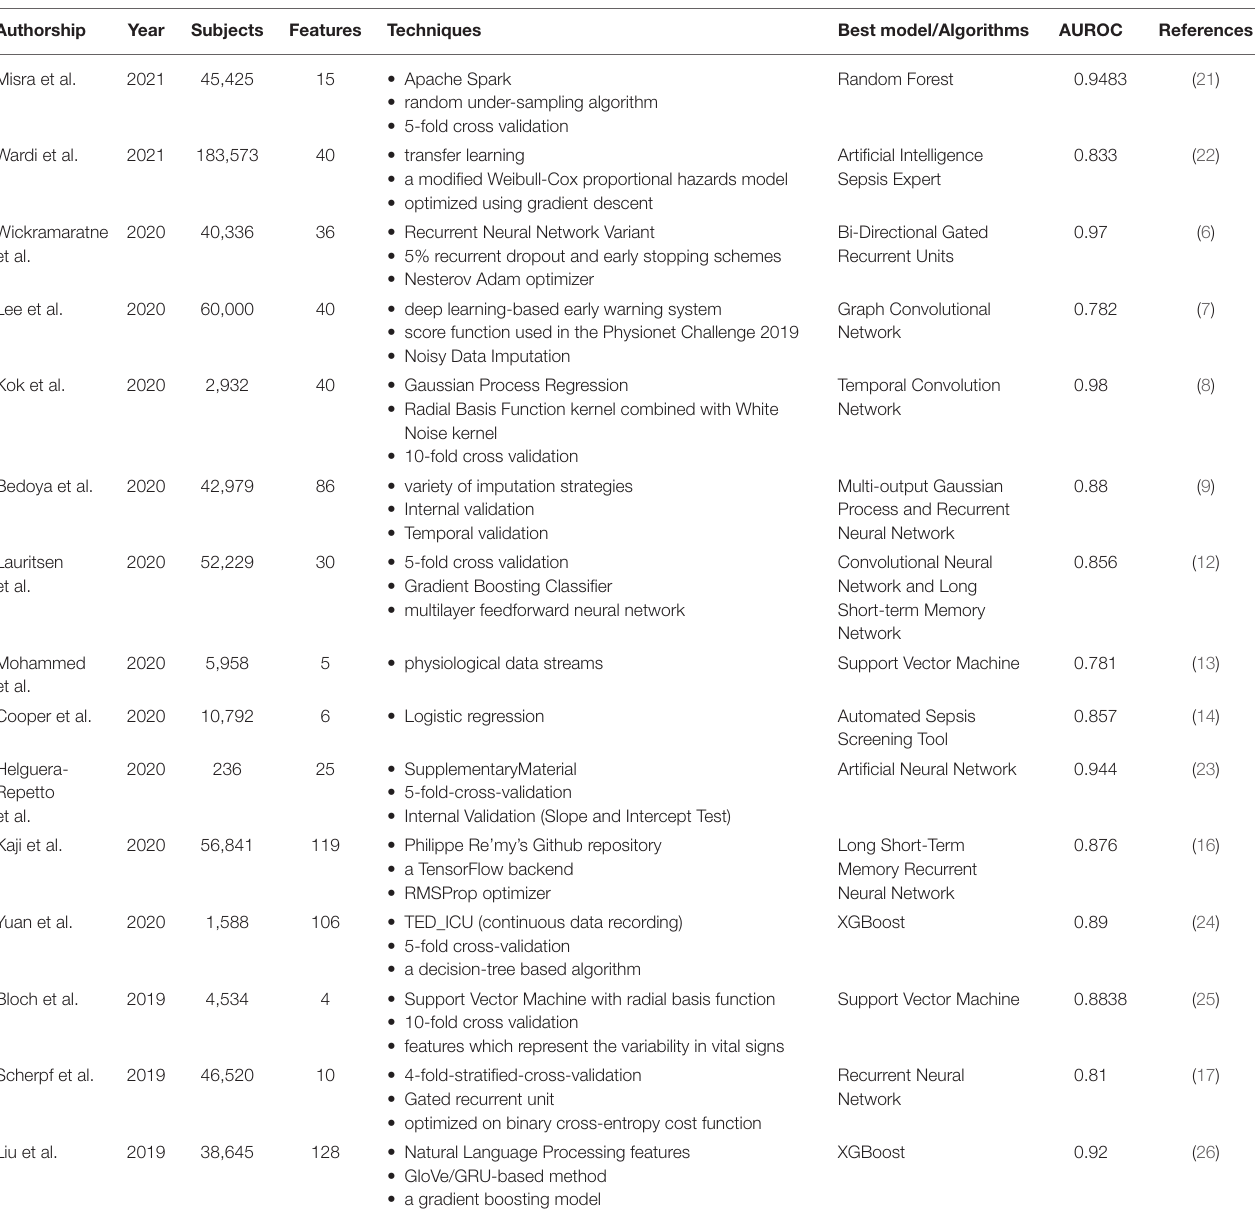
TABLE 1 | Summary of the results from related works on the prediction of sepsis